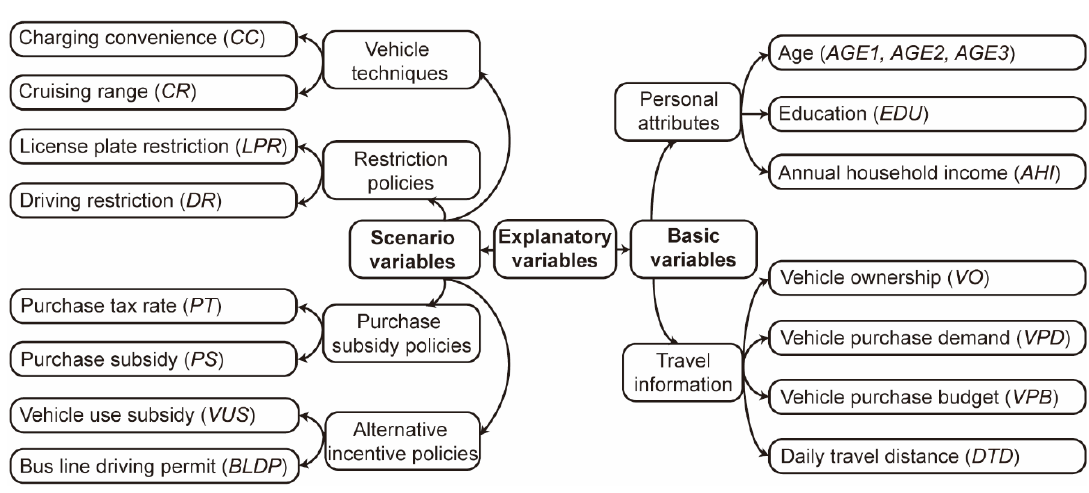
Figure 2. Explanatory variables classification.